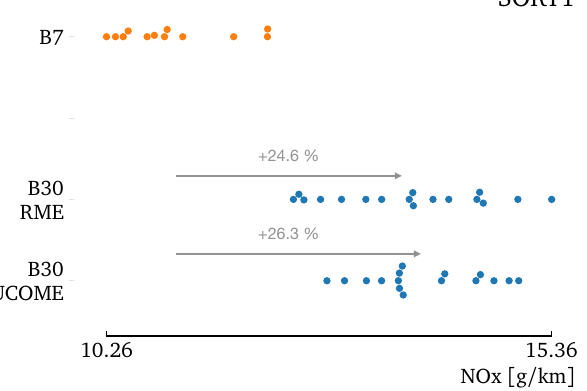
Figure 6. The NOx emission rate per kilometre of each SORT 1 repetition shows higher NOx emissions when the bus is fueled with B30 RME and B30 UCOME compared to B7. The maximum measurement uncertainty with 95% probability amounts to 0.14 g/km .